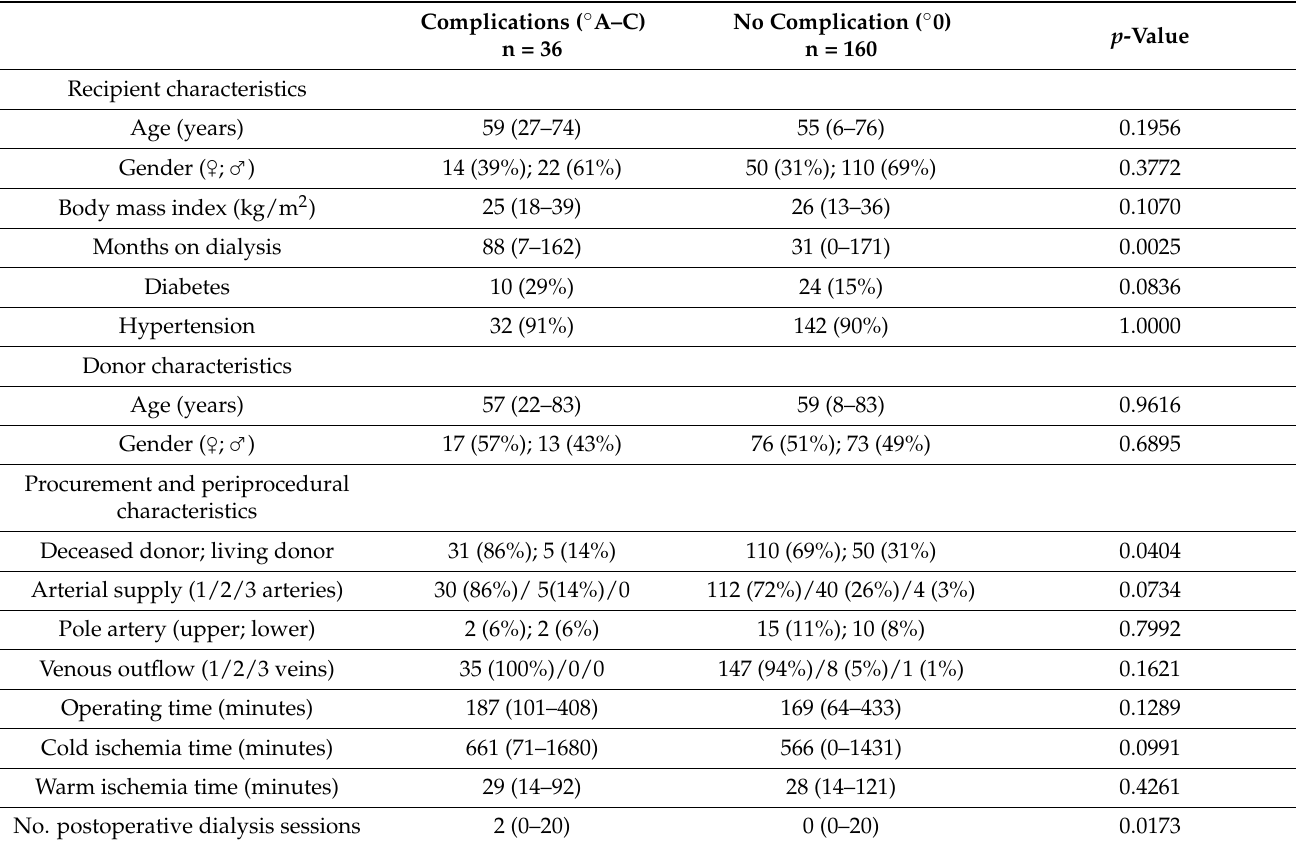
Table 2. Comparison of recipient, donor, and periprocedural characteristics between recipients with the occurrence of postoperative ureterovesical anastomosis complications and those without kidney transplantation (n = 196). Quantitative variables are expressed as median, minimum, and maximum. For qualitative factors, absolute and relative frequencies are